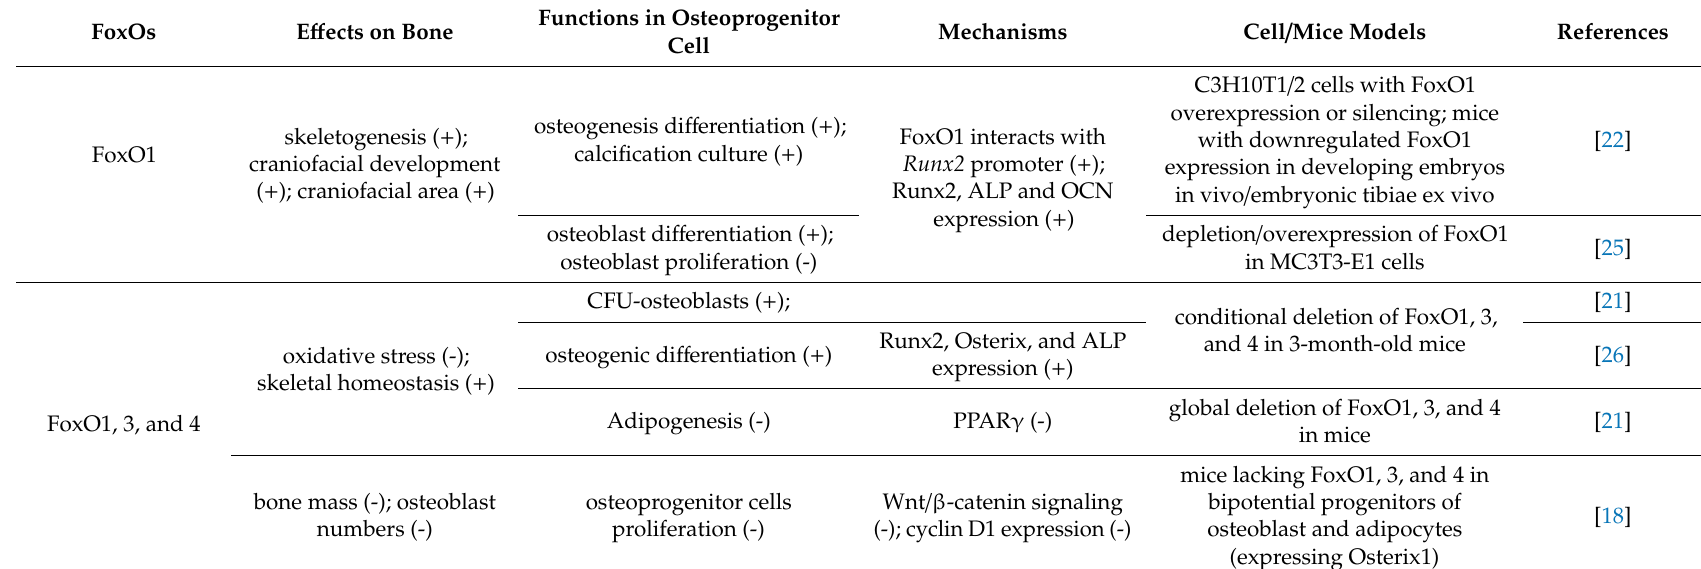
Table 1. The bidirectional regulation role of FoxO transcription factors (FoxOs) in osteoprogenitor